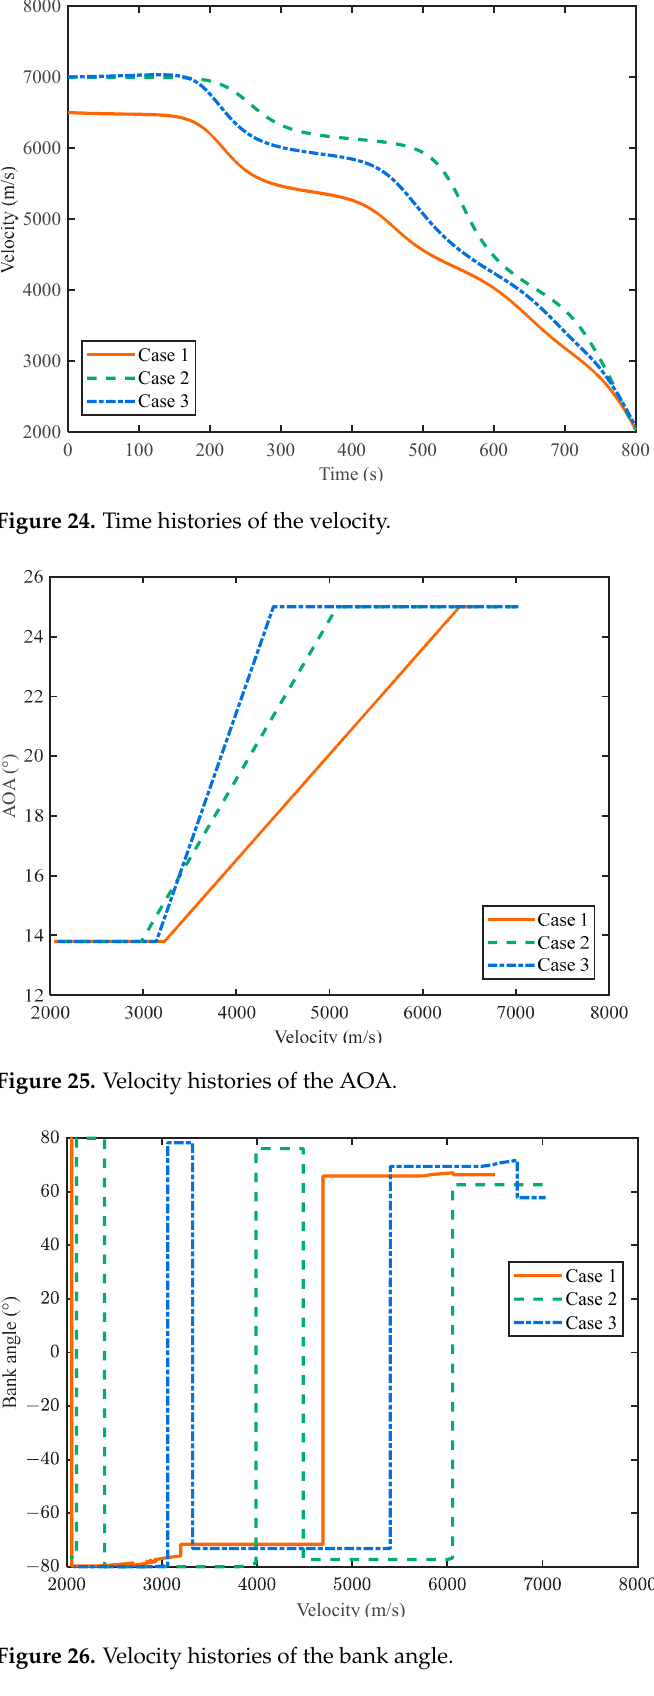
Figure 23. 3D reentry trajectory.